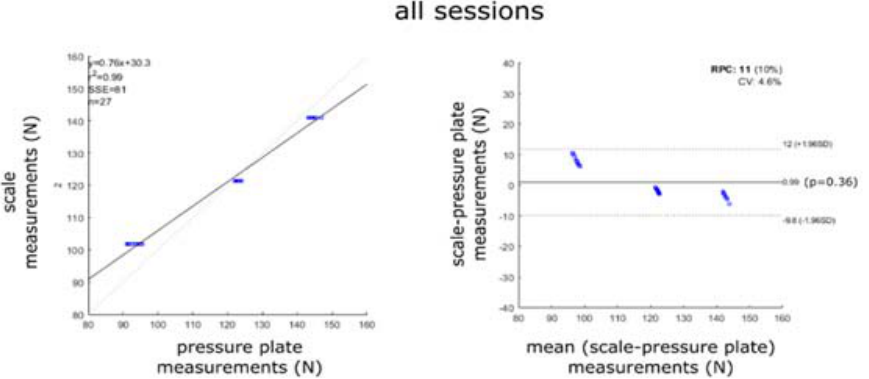
Figure 2. Bland–Altman plots for each of the three measurements’ sessions (top), and of all measure- ments across all sessions (bottom). Correlation coefficient (r 2 ); sum of square error (SSE), variation coefficient (CV), standard deviation (SD).